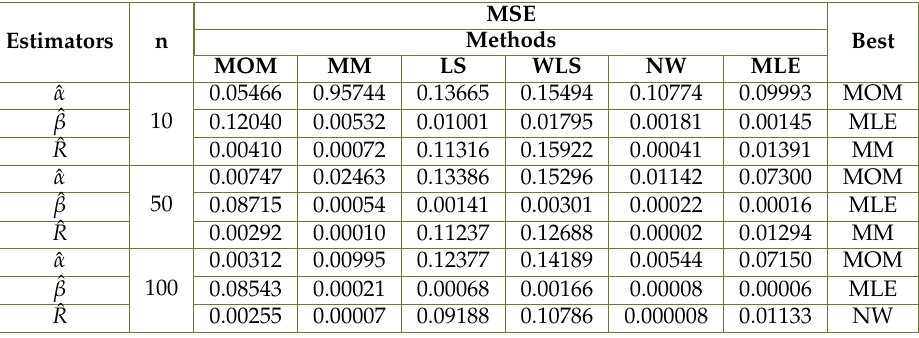
Table 2. Estimated values for ( α , β ) and ( R ) using ( E 1 )